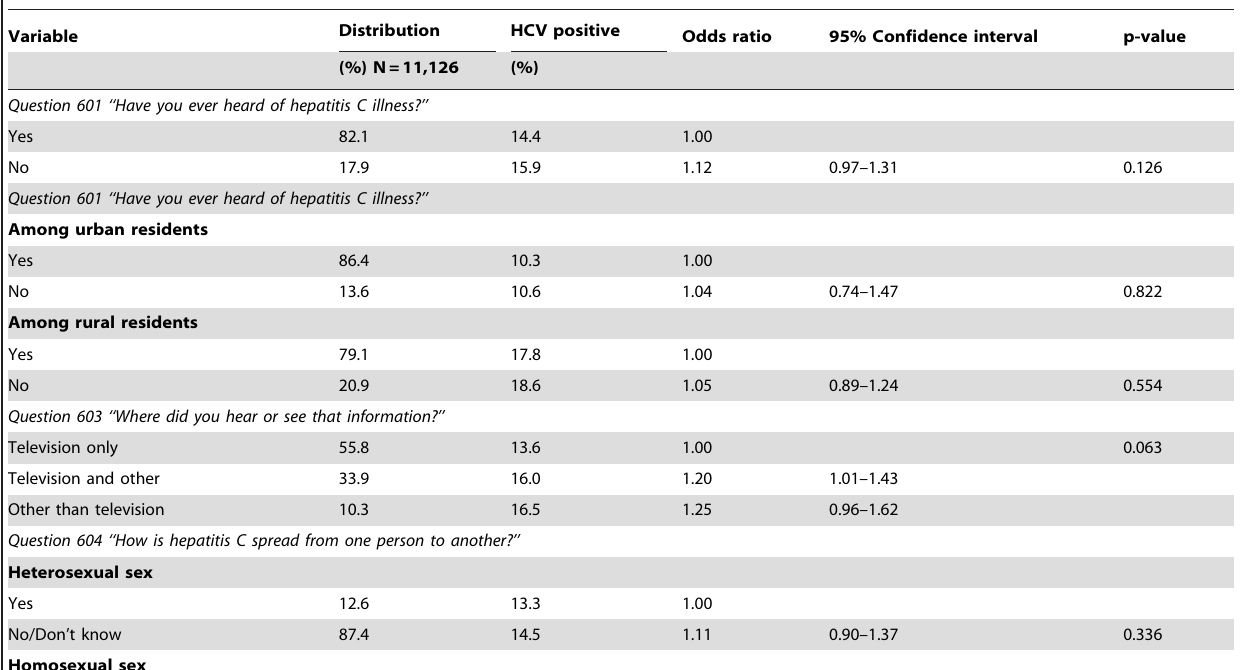
Table 1. Prevalence of HCV antibody by response to HCV knowledge-related